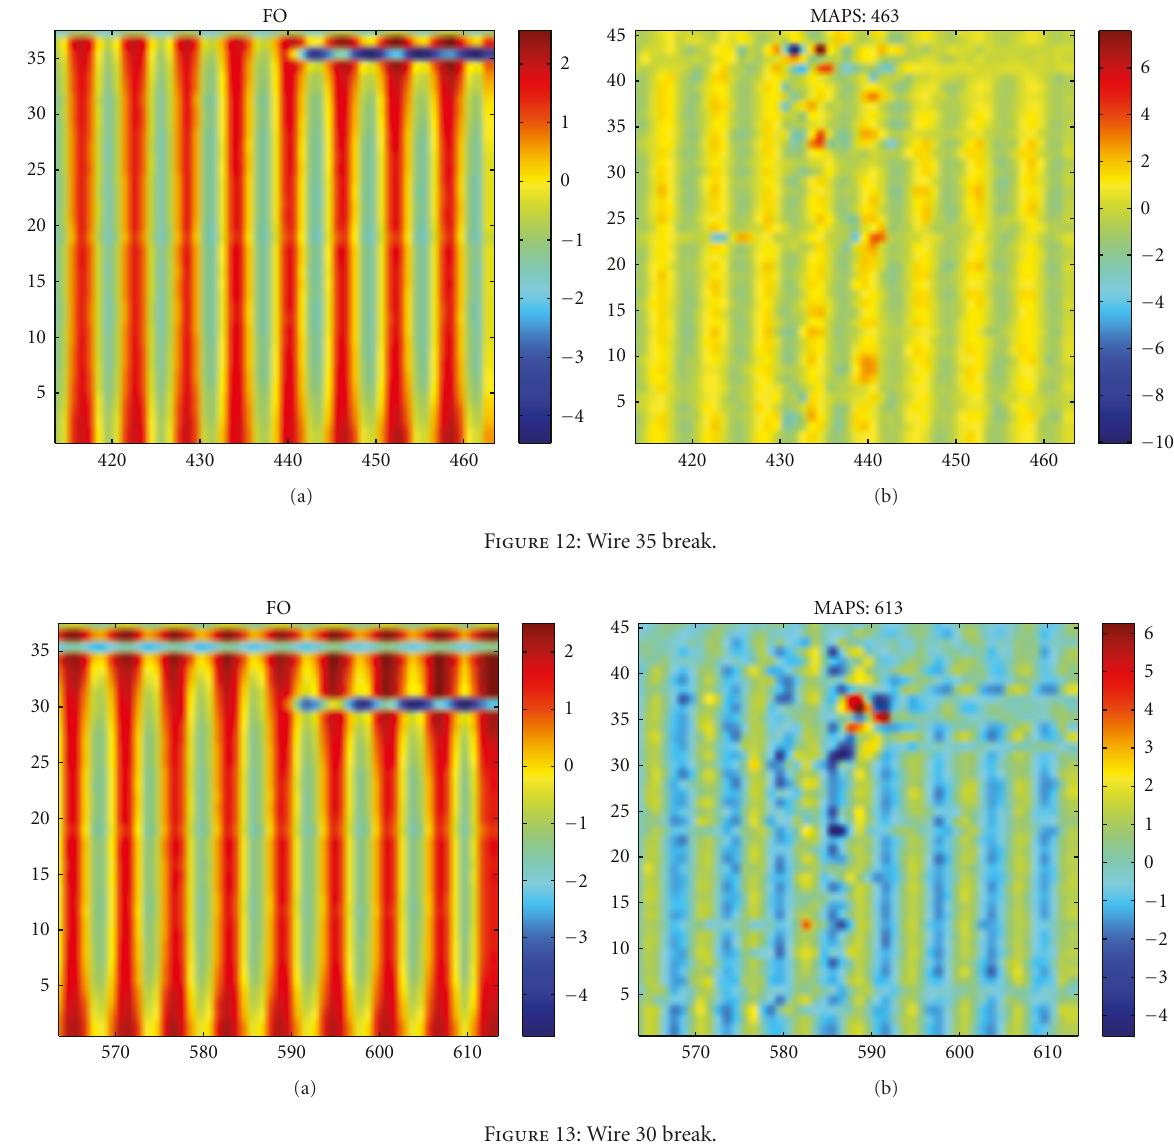
Figure 13: Wire 30